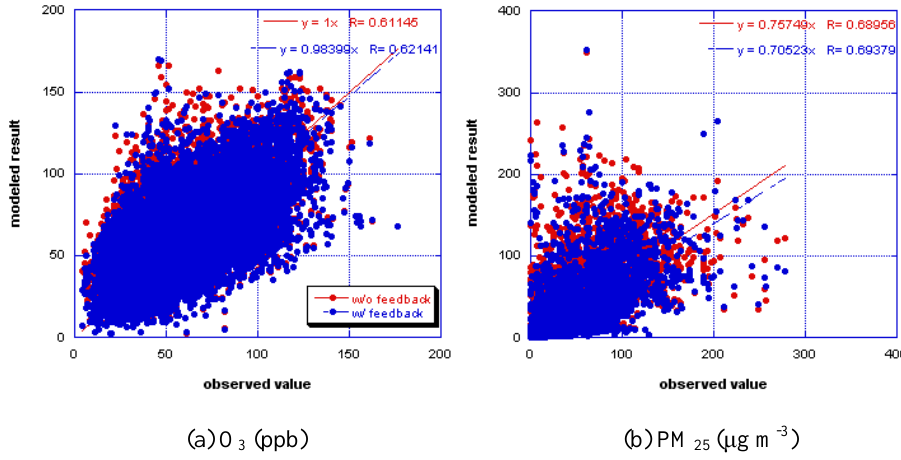
Figure 9. Scatter plots of model, with (blue) and without (red) feedback, and observed daytime (a) O 3 and (b) PM 2 . 5 ambient levels. Also shown are the slope and correlation coefficient ( R ).